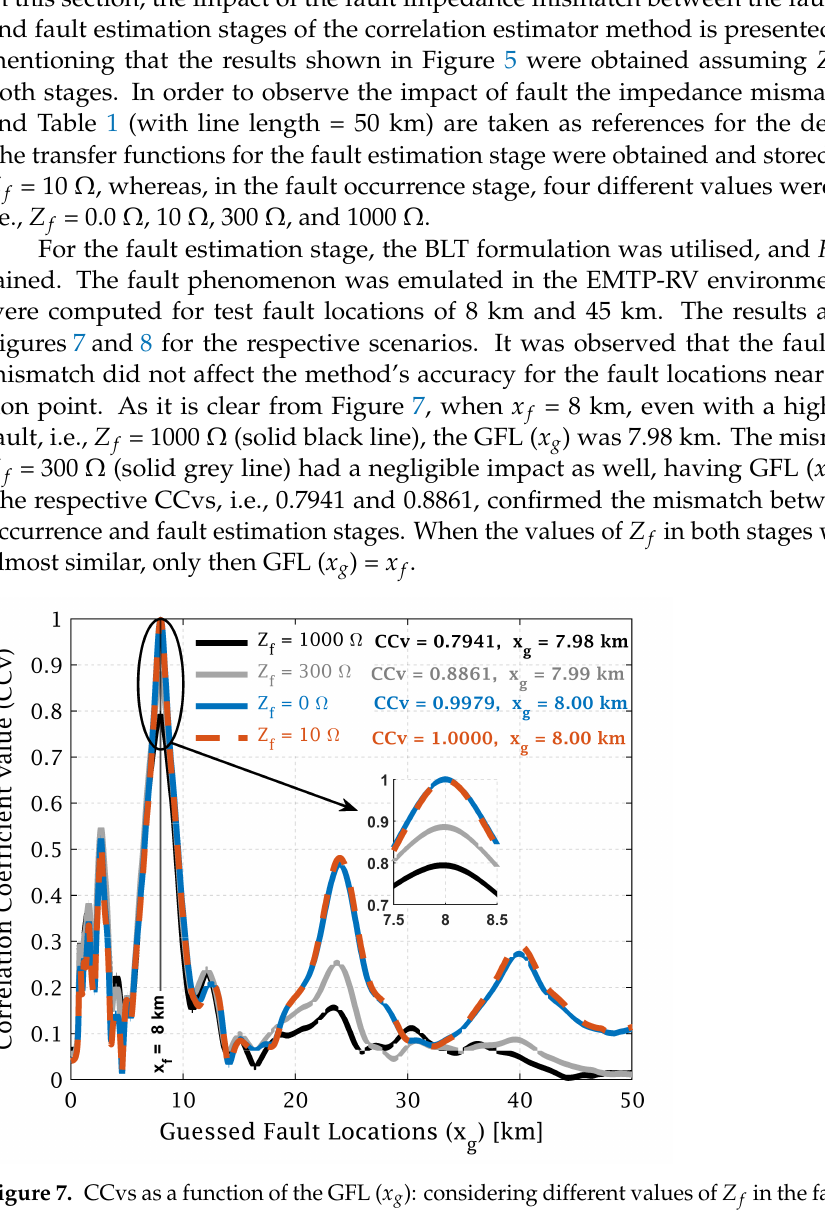
Figure 7. CCvs as a function of the GFL ( x g ): considering different values of Z f in the fault occurrence stage, while in the fault estimation stage, Z f = 10 Ω ; the test fault location is 8